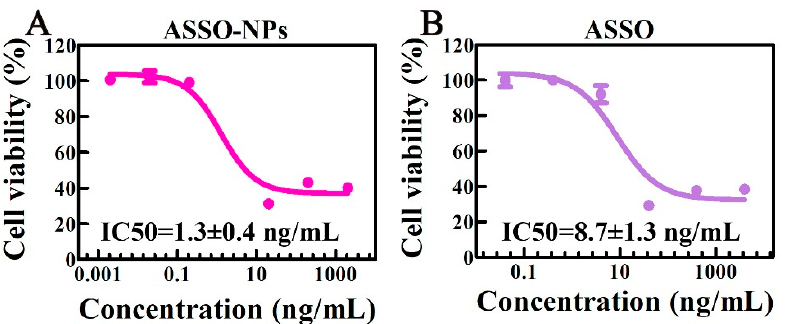
Figure 4. The cytotoxicity of ASSO-NPs or ASSO. Fitting inhibition curve of ( A ) ASSO-NPs or ( B ) ASSO on 4T1 cells.